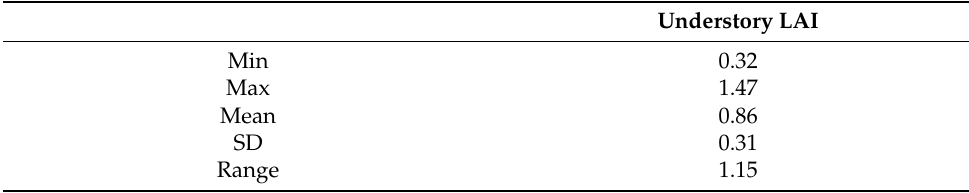
Table 1. Statistics of in situ understory LAI measurements at the plot level (plot number =